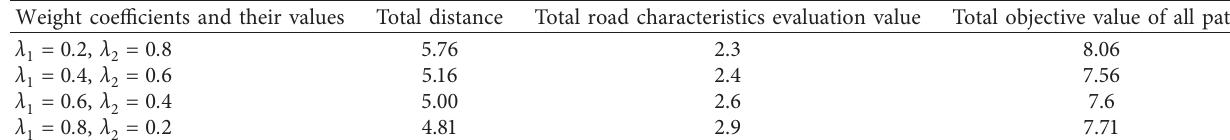
Table 8: The results under different values of λ